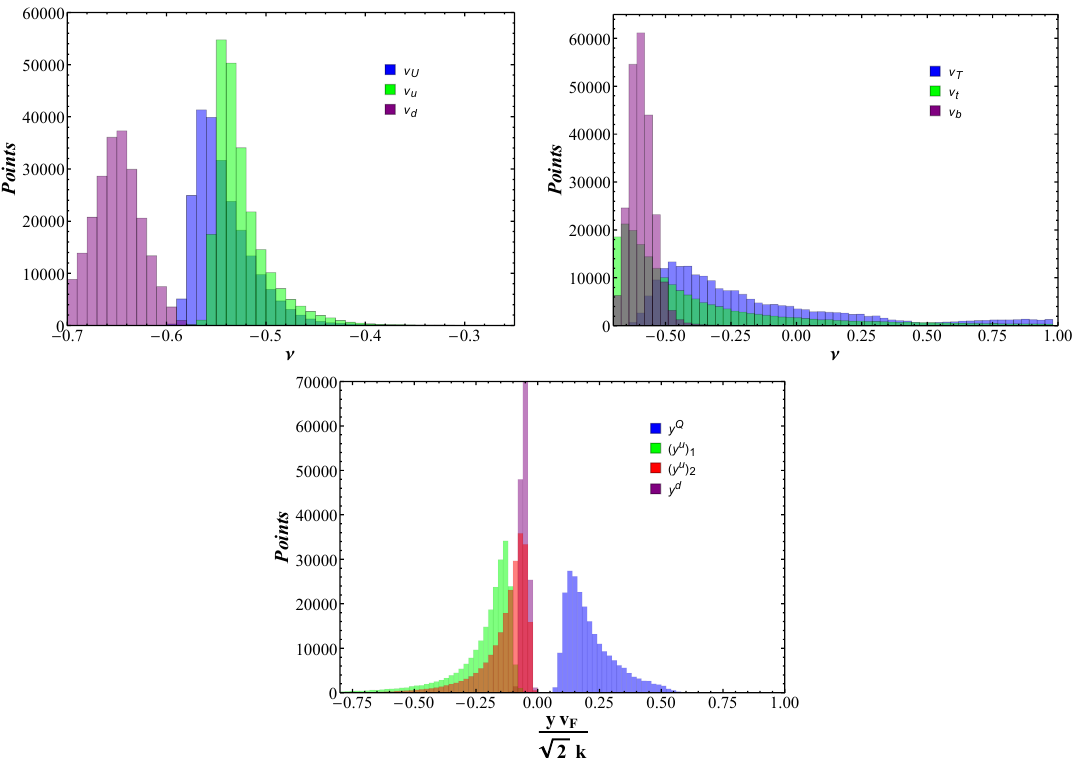
Figure 1. Bulk Localization (top) and Yukawa Coupling (bottom) parameters for sampled points in parameter